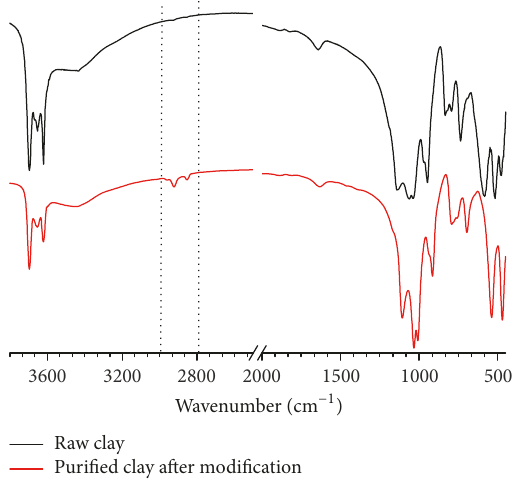
Figure 2: FTIR spectra of raw clay and modified clay.